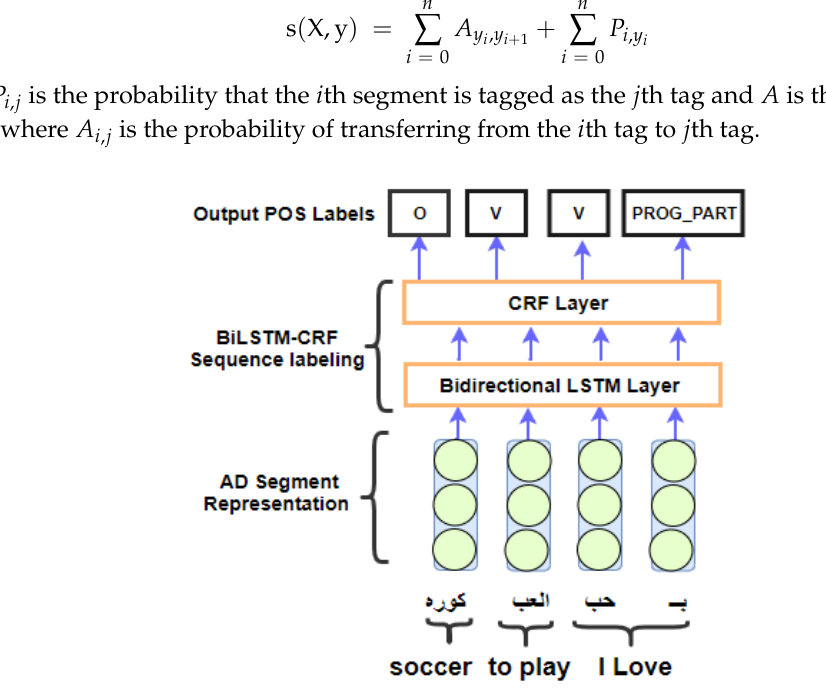
Figure 1. Arabic Dialect Segment-Level Bi-LSTM-CRF part-pf-speech tagging model.